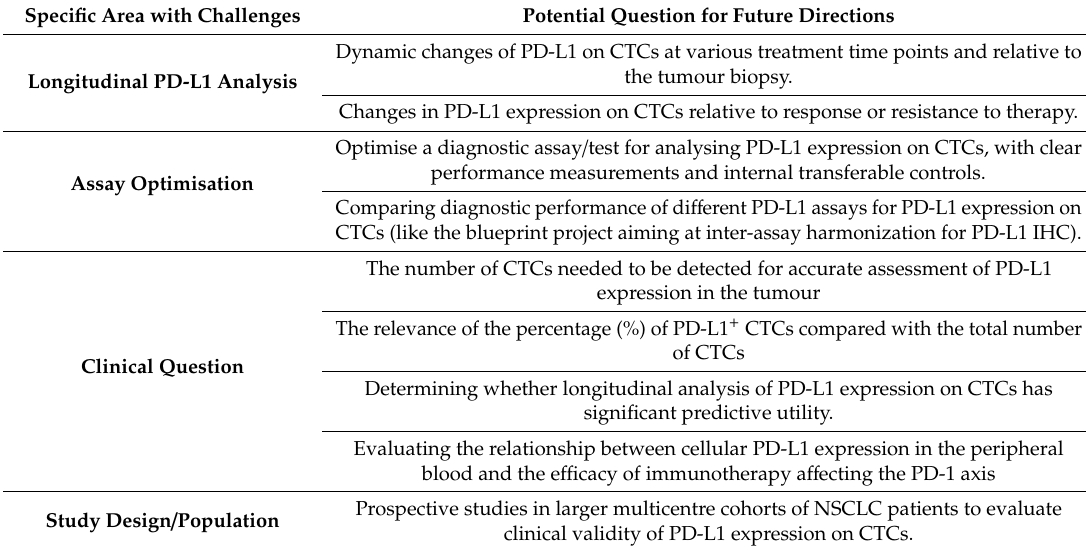
Table 2. Challenges and opportunities for PD-L1 assessment on